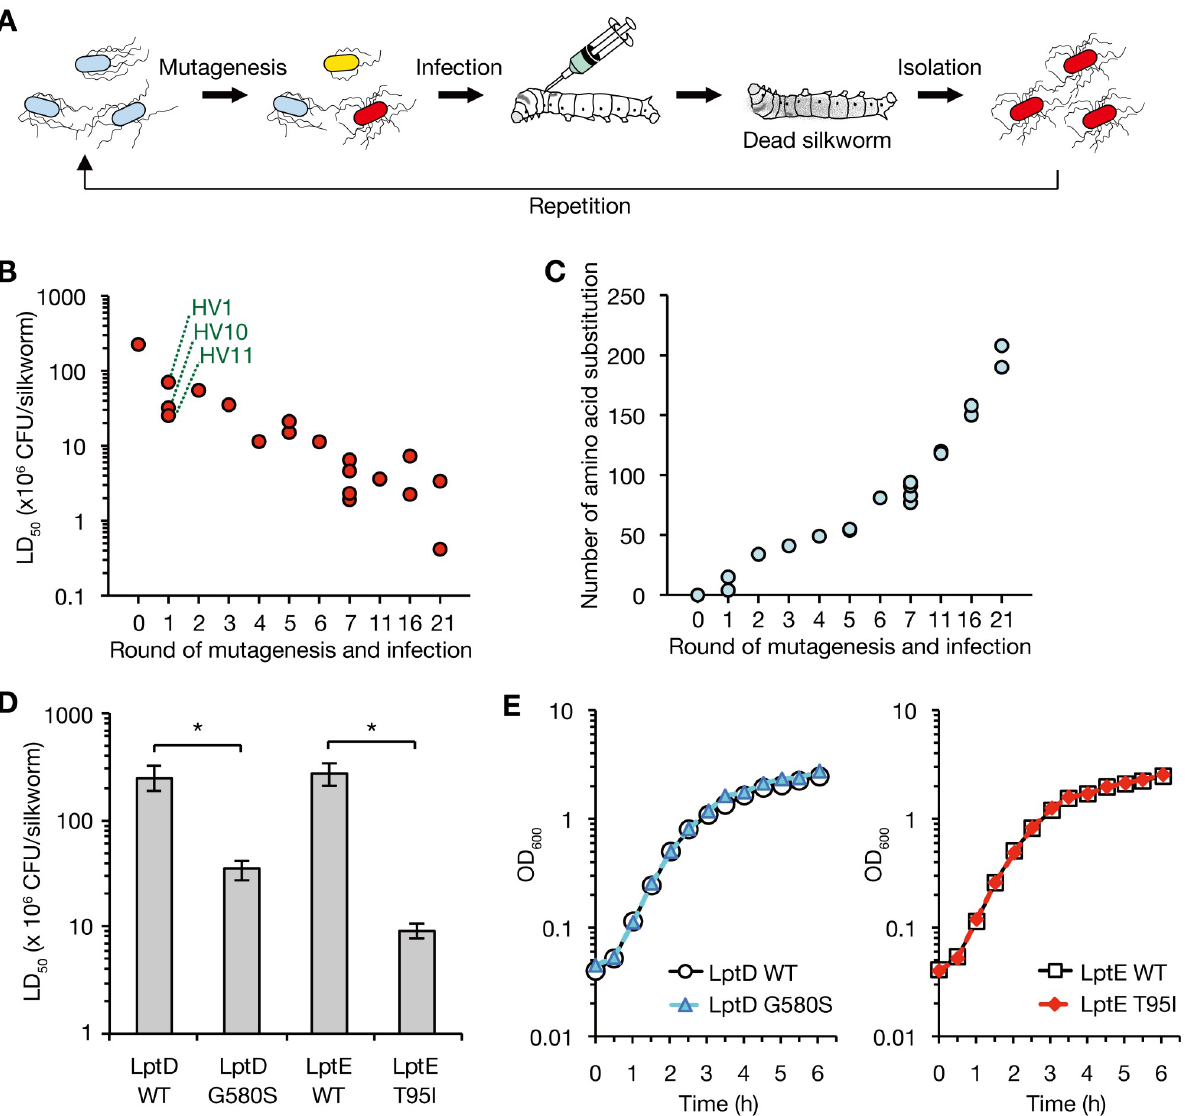
Fig 1. Isolation of E . coli mutants with high virulence by experimental evolution. (A) A schematic representation of experimental evolution utilizing the silkworm infection model. E . coli strain treated with a mutagen was injected into silkworm. After the silkworm died, E . coli strains were isolated from the dead silkworm hemolymph. The mutagenesis and infection were repeated for 21 cycles. (B) An E . coli single colony isolated by the experimental evolution was cultured overnight, serially diluted, and injected into silkworms. Silkworm survival was determined at 48 h after the injection and the LD 50 was determined by logistic regression. The horizontal axis represents the number of times the mutagenesis and infection experiments were performed. Each colony isolated from a dead silkworm that appeared different from the others was examined for its killing activity. The three symbols marked by green dotted lines represent the HV1, HV10, and HV11 strains. (C) E . coli strains isolated in the experimental evolution were subjected to whole genome sequencing and the number of amino acid substitutions is presented. The horizontal axis and strains are the same as in B. (D) Overnight cultured bacterial cells of the LptD WT, LptD G580S, LptE WT, and LptE T95I strains were serially diluted and injected into silkworms. Silkworm survival was determined at 48 h after the injection and the LD 50 was determined by logistic regression. Data shown are the mean ± standard errors from three independent experiments. The asterisk represents a p value less than 0.05 (Student’s t test). (E) E . coli strains of LptD WT, LptD G580S, LptE WT, and LptE T95I were aerobically cultured in LB broth at 37˚C. The vertical axis represents the OD 600 of bacterial culture, and the horizontal axis represents the culture